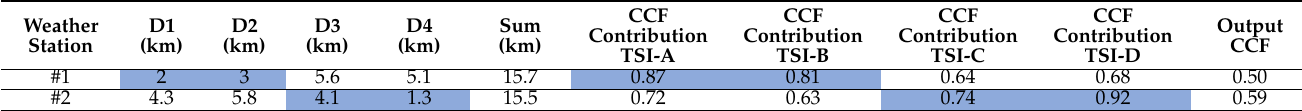
Table 2. Results of the parameters with respect to both weather